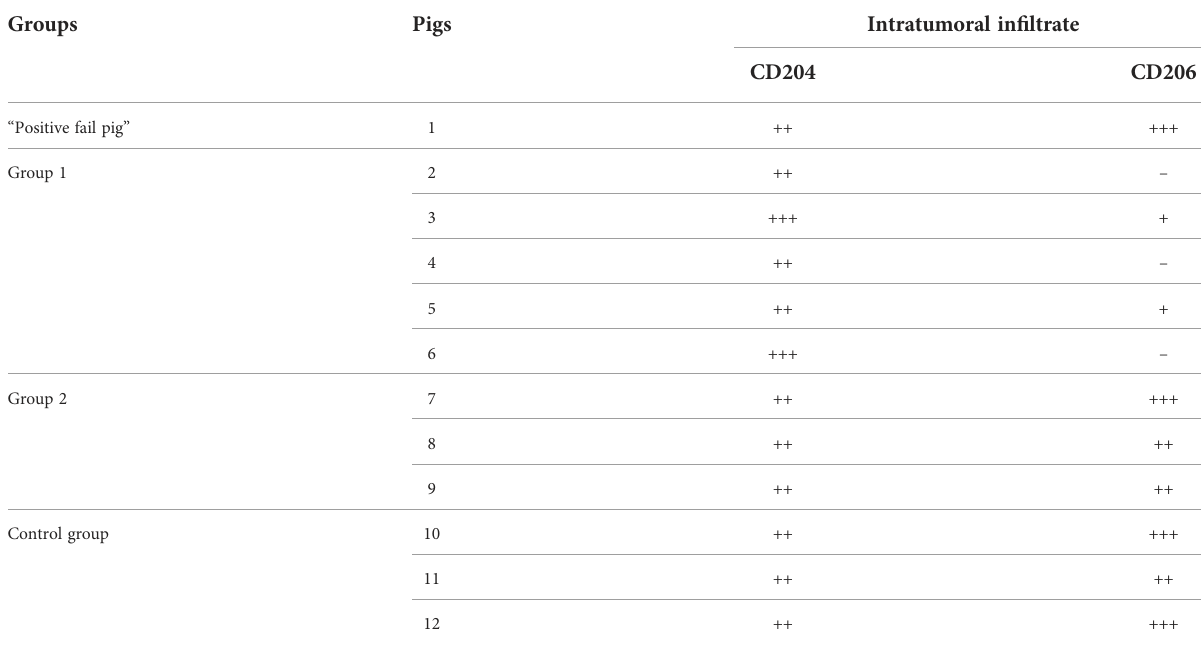
TABLE 6 Evaluation of macrophage and dendritic cells in fi ltration in the brain tumor. Groups Pigs